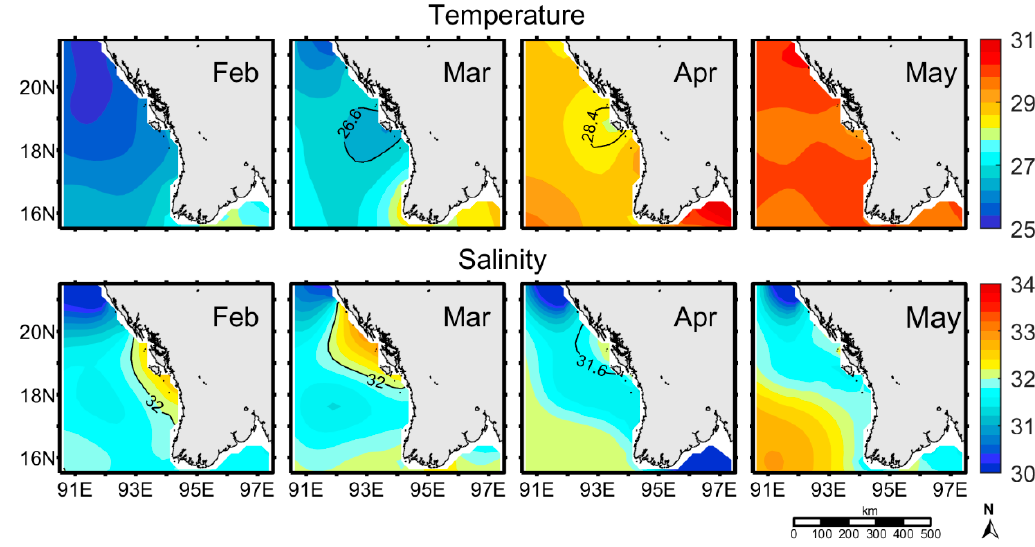
Figure 4. The climatological distributions of surface temperature (upper panels, unit: °C ) and salinity (lower panels, unit: psu) in the waters of Myanmar from February to May. Temperature and salinity are from climatological monthly data of WOA18.